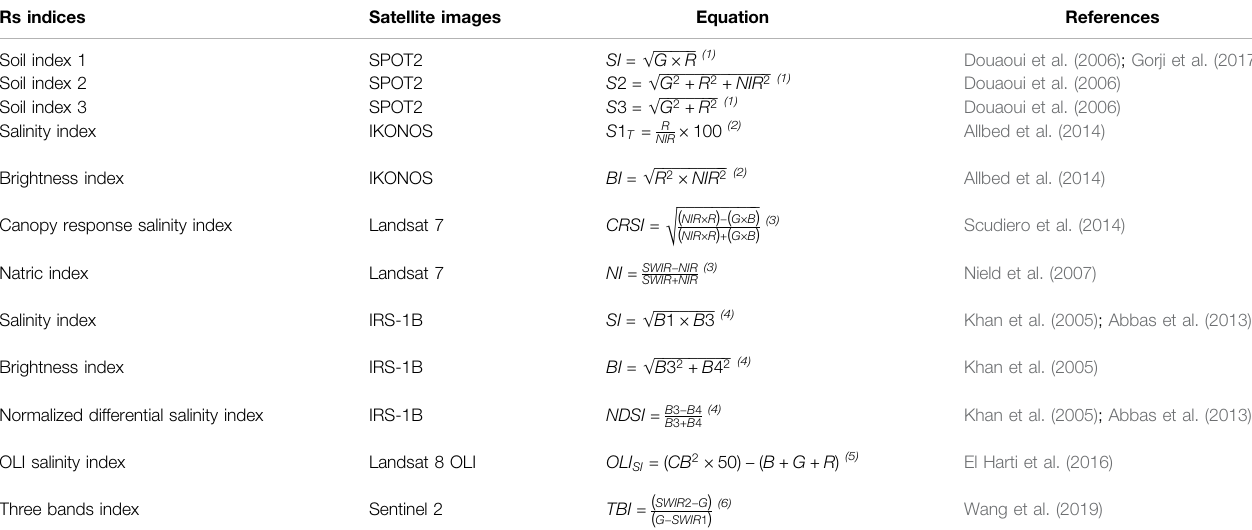
TABLE 4 | Spectral indices used for soil salinity mapping and